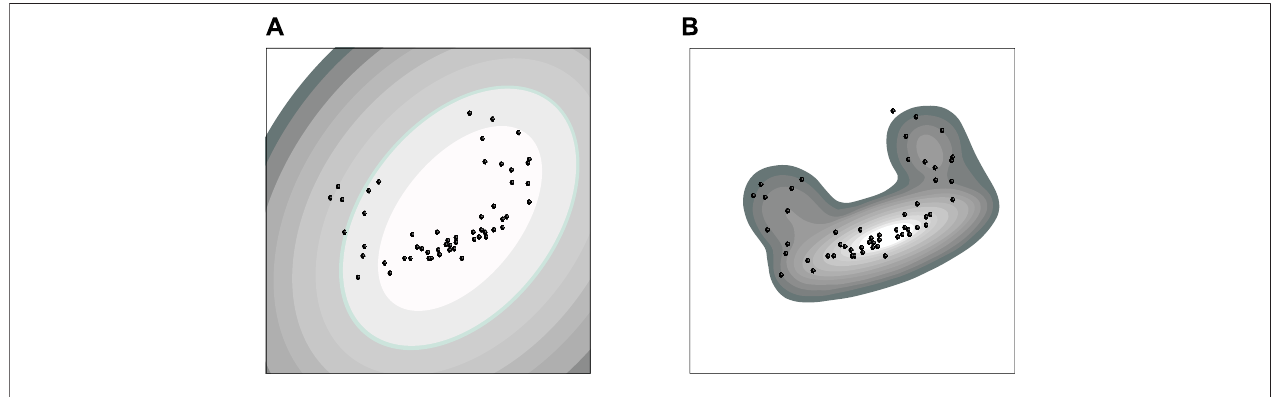
FIGURE 4 | Gaussian model and the mixture of Gaussian model: (A) The Gaussian model imposes the ellipsoidal density model on the two-dimensional data; (B) the MoG model is a linear combination of Gaussian distributions. Apertures of diverse sizes are their transformations with different outlier detection